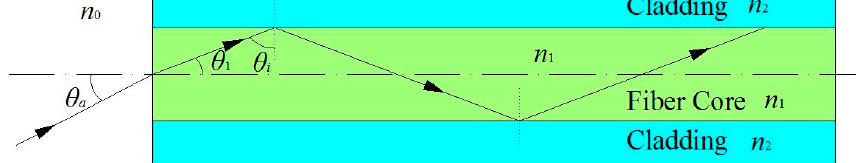
Figure 11. Light transmission in the step index fiber [8].